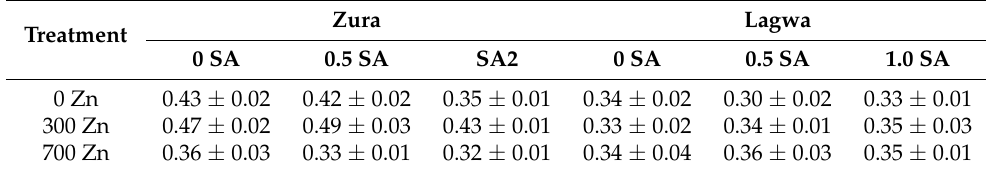
Table 4. Translocation factors of Zn (TF) ( ±